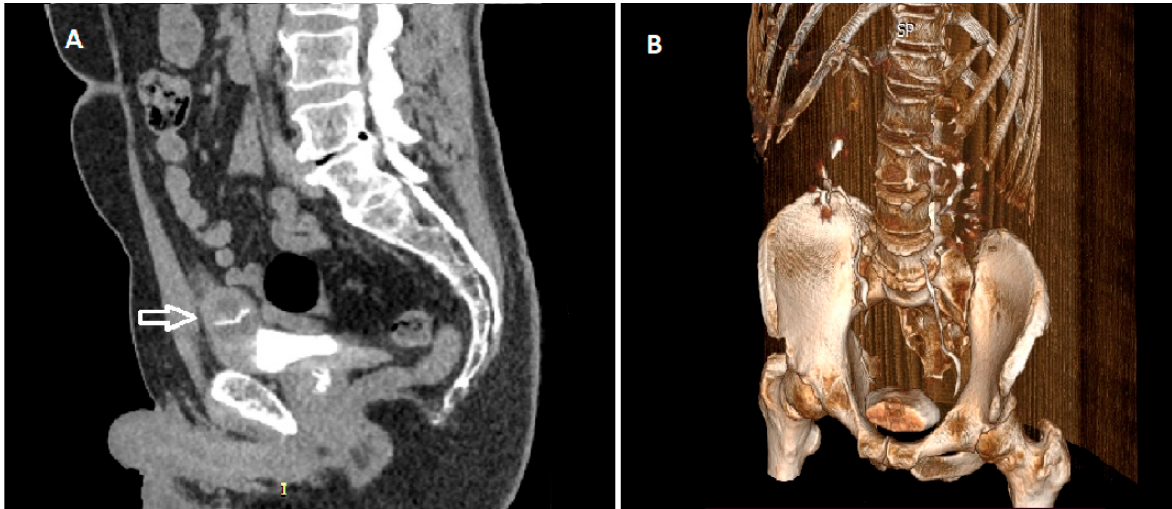
Figure 2. CT urography shows a tumour at the dome of the urinary bladder (arrow)—sagittal plane ( A ) The 3D reconstruction also shows a lesion at the dome of the urinary bladder ( B